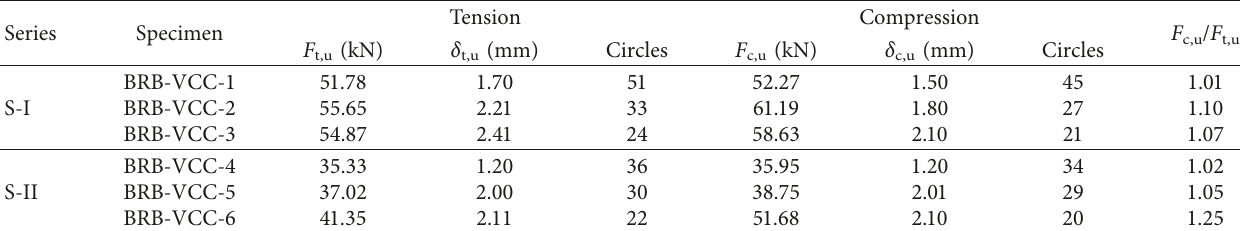
Figure 12: Skeleton curves of specimens. (a) S-I (b) S-II. Table 3: Main experimental results of the specimens.